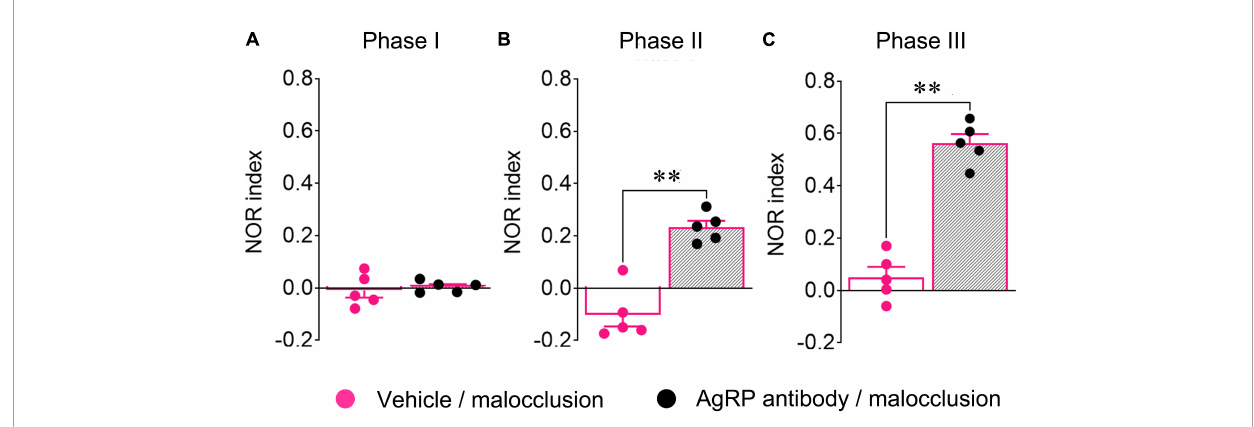
FIGURE5 Novel object recognition (NOR) indices of mice subjected to intracerebroventricular (icv) anti-AgRP antibody administration. Anti-AgRP antibody (0.1 µ g/2 µ L/mouse) was administered intracerebroventricularly to all mice from Day 25 to 30. NOR tests were performed 30 min after icv administration on Day 30. Phase I (A) , Phase II (B) , and Phase III (C) NOR indices of Malocclusion/powder group mice administered vehicle ( n = 5) or antibody ( n = 5). Data are represented as means ± SEM. Differences were considered significant at ** p <